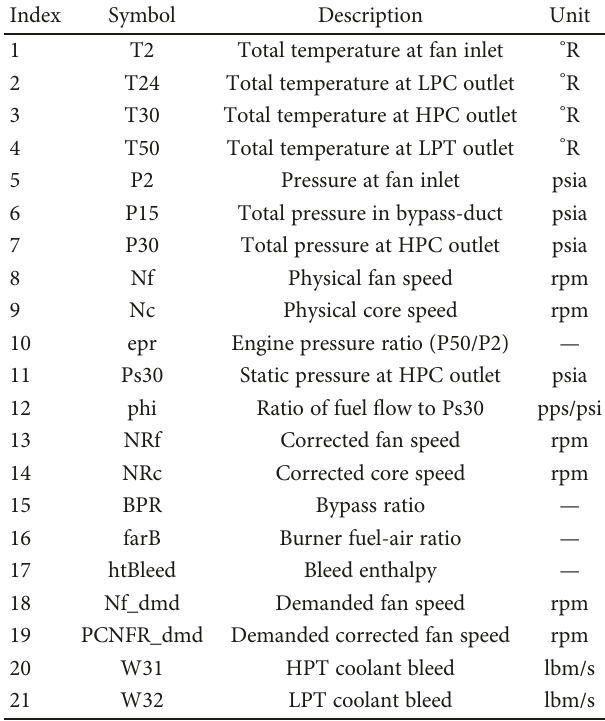
Table 1: Description of the sensor signals for the aircraft gas turbine engine.